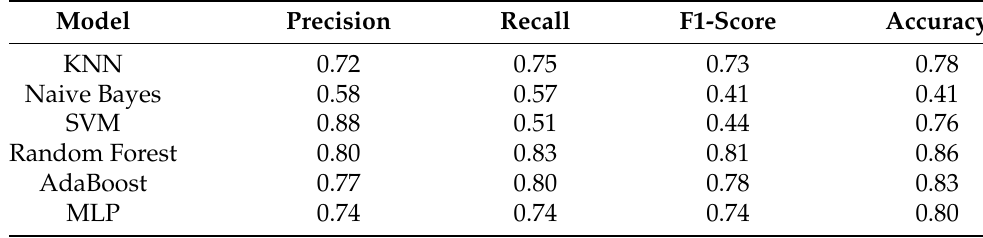
Table 11. Classification Results Total